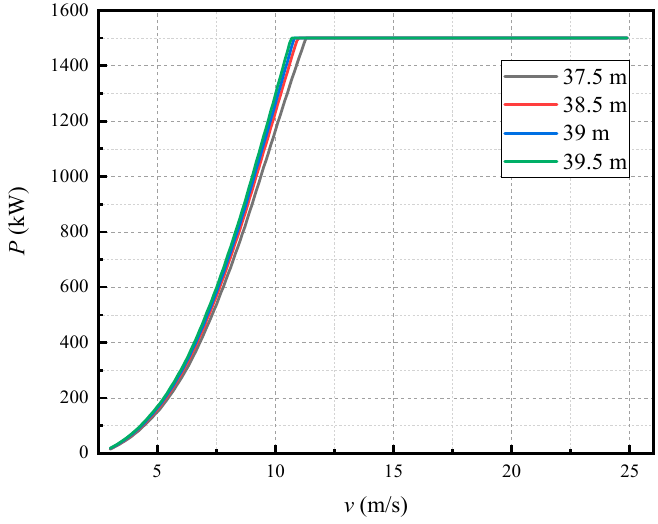
Figure 6. Steady power curves of turbines with different blade lengths.